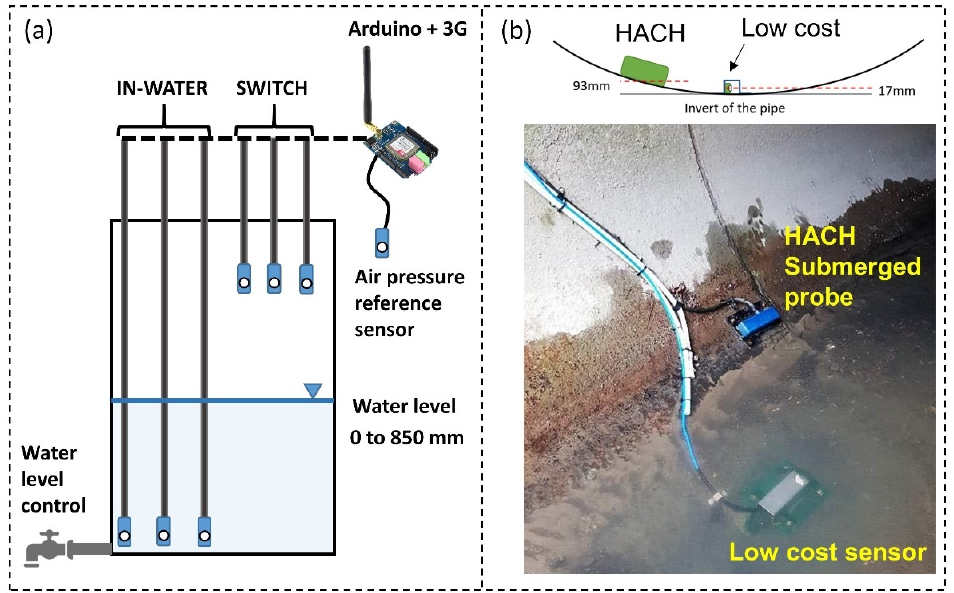
Figure 2. ( a ) Lab experiment setup in a water column for testing the proposed water depth sensor: water level is controlled through a tap and the level was changed between 0 and 850 mm; ( b ) Field installation layout to compare the performance between the low-cost and HACH submerged probe; the HACH sensor is 93 mm above the invert of the pipe and the low-cost sensor is 17 mm above the invert.